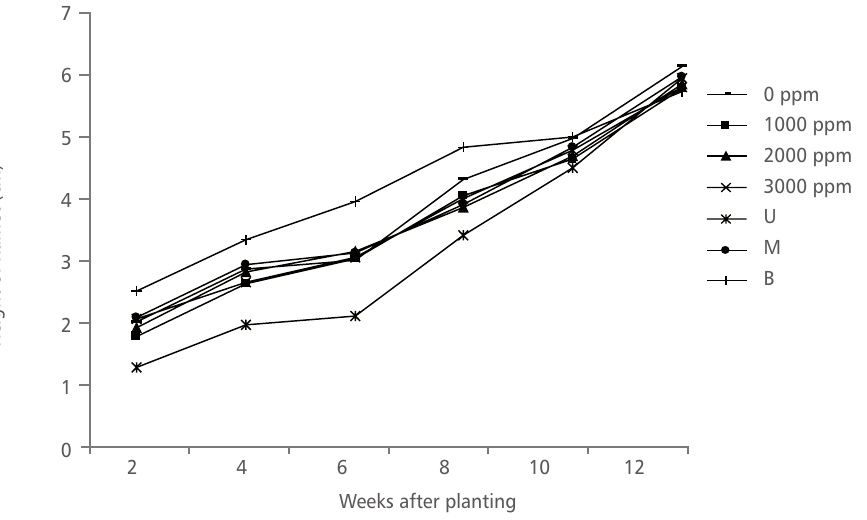
FIGURE 3. Height growth of D. tripetala ’s Ramets using different IBA hormonne concentrations and nodal positions (U= upper node, M = middle node and B = basal node)